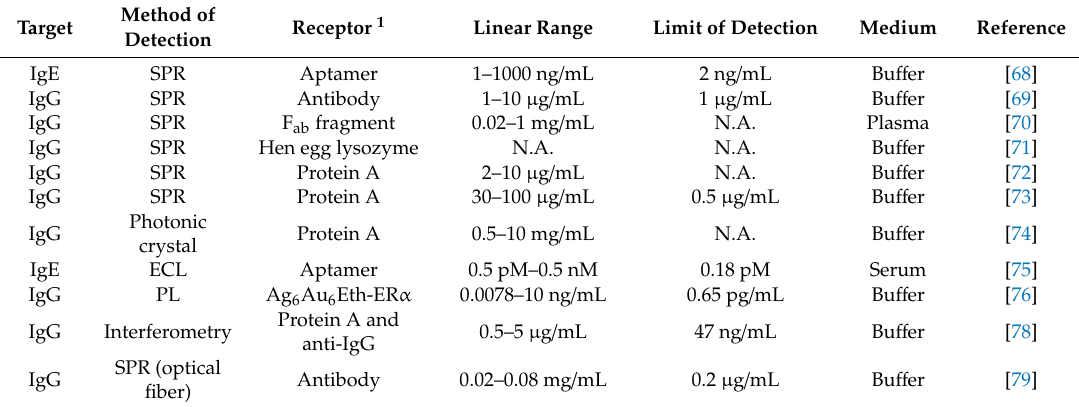
Table 3. Characteristics of the optical biosensors for detecting immunoglobulins (N.A., not available).